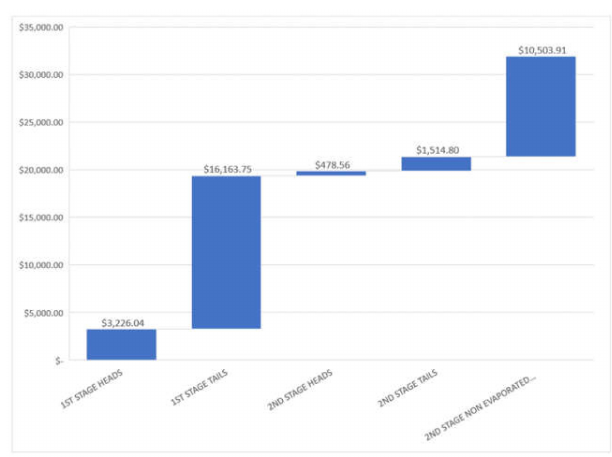
Figure 5. Mean mixture pricing in USD for residual streams studied for a batch of for a 100,000 tequila 40%A.V. liter production in a